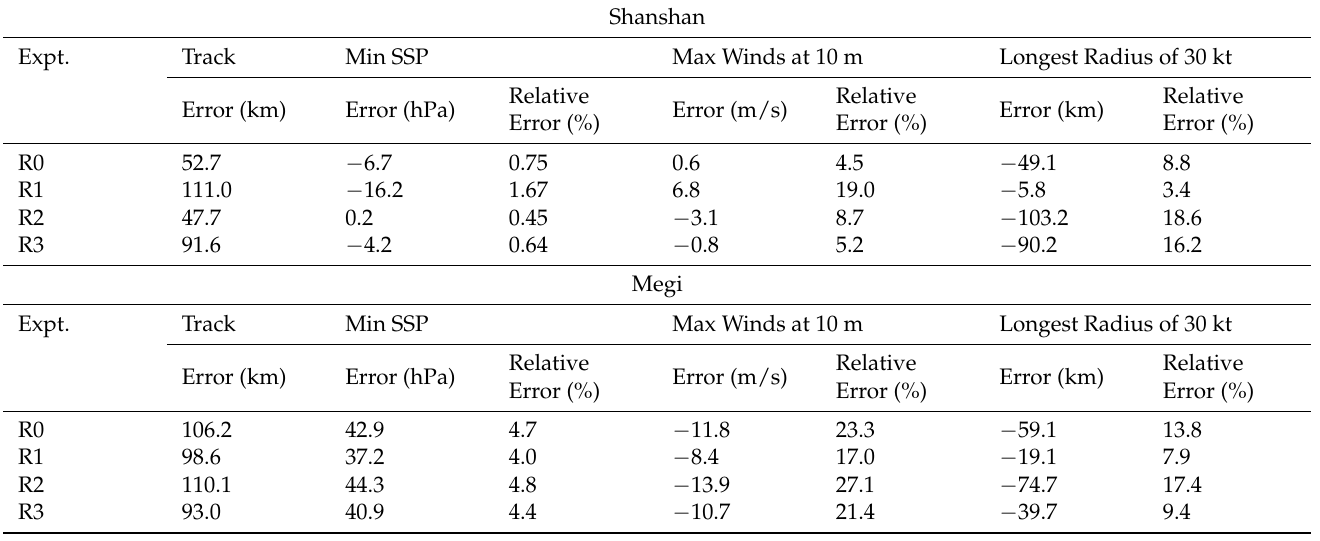
Table 2. Statistics for the track, maximum wind speed at 10 m, minimum sea surface pressure (SSP), and longest radius of 30 kt winds, comparing modeled and best track data. See Section 3.1 for details of the different